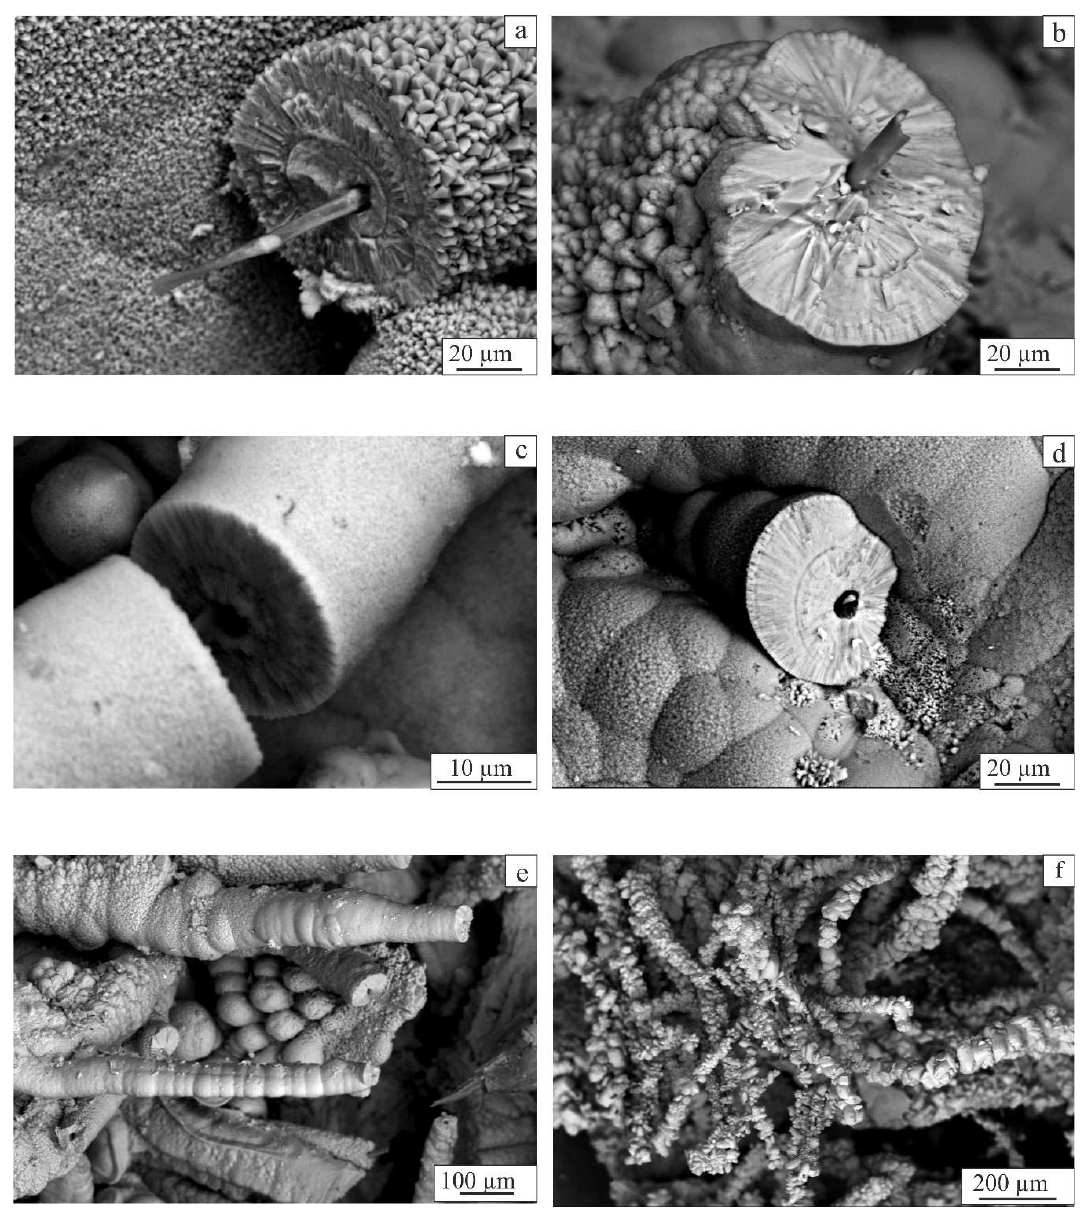
Figure 7. Mineralized tubular aggregates: ( a – d ) with preserved fungal hyphae in the central part; and ( e , f ) diversity of calcite tubular aggregates morphology.